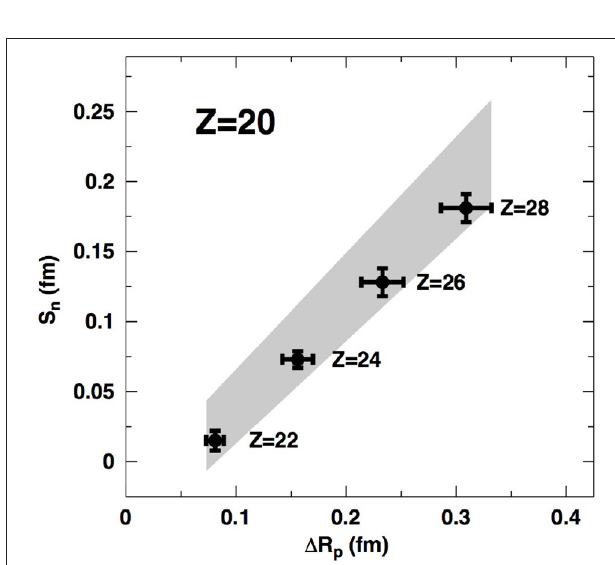
FIGURE 3 | As in Figure 2 but for Table 5 .